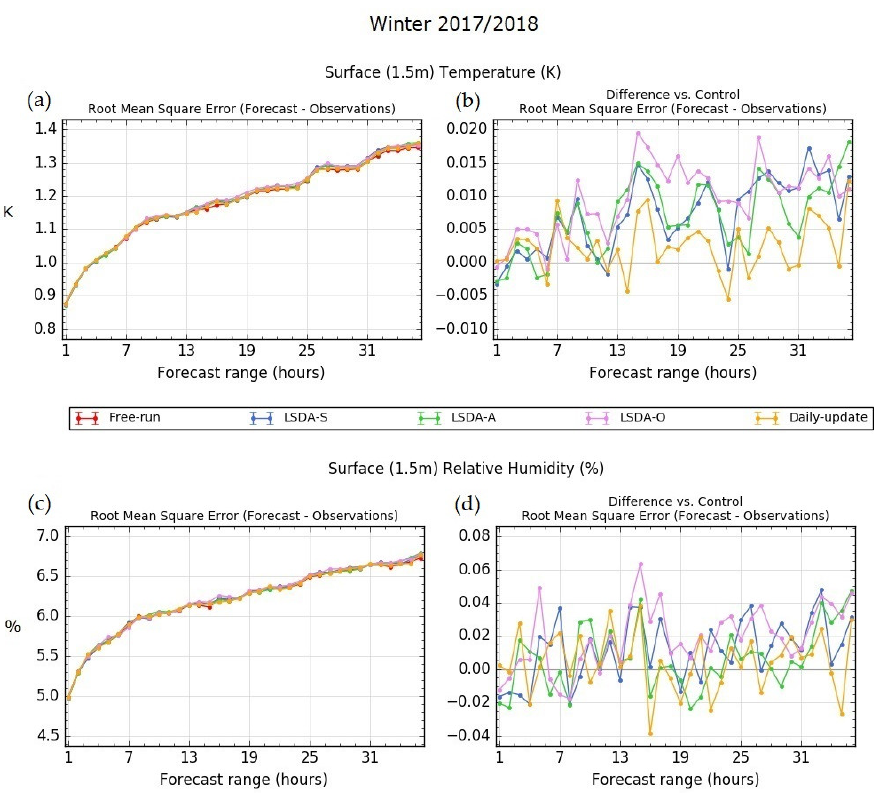
Figure 6. Winter forecasts from 1 December 2017 to 31 January 2018 compared to observations. Root mean squared errors or RMSE in surface (1.5 m) temperatures (Kelvin) ( a ) and in relative humidity (%) ( c ) computed for UKV forecasts against ground-based SYNOP observations for all forecast ranges up to T + 36 h. Shown are the control run without LSDA or free-run (red), daily-update (yellow) and the experiments: assimilation of pseudo-observations of screen-level temperature and humidity only (blue), assimilation of ASCAT only (green) and assimilation of both observation types (pink). Panels ( b , d ) show the RMSE di ff erence between the free-run and each of the daily-updates and the three experiments, such that a negative result means improvement of the experiment over the